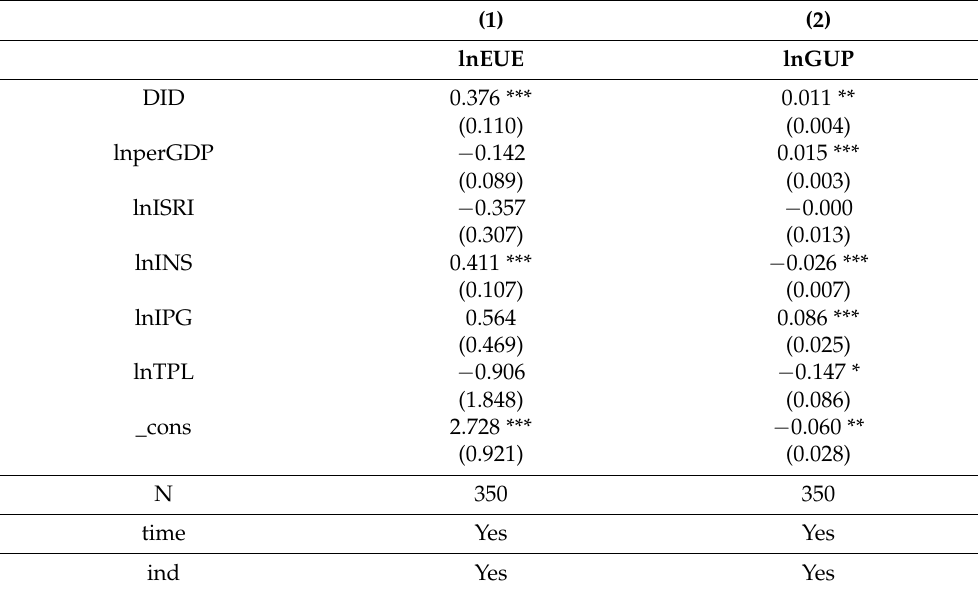
Table 5. Tests for the mediating role of energy use efficiency and the share of green patented technologies in carbon